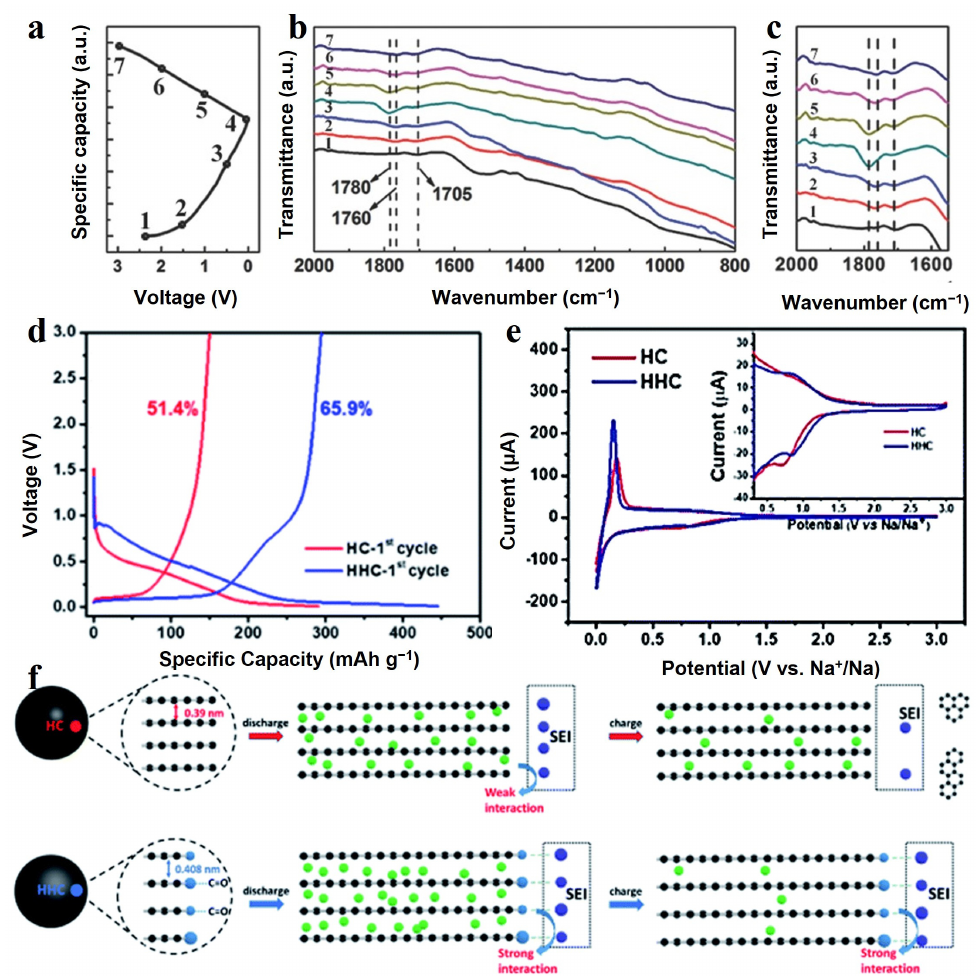
Figure 4. ( a ) Charge/discharge profile of the electrode during the initial cycle at 0.2 A g − 1 , ( b , c ) ex situ FTIR spectra of electrode at the selected potentials indicated in ( a ) [73]. Copyright 2017, Wiley-VCH. ( d ) Galvanostatic charge and discharge profiles of HC and HHC at the first cycle at current density of 100 mA g − 1 . ( e ) CV curves of HC and HHC electrode, inset is the magnified image. ( f ) Proposed mechanism via stabilized solid electrolyte interface between the oxygen functional group and electrolyte [74]. Copyright 2020, Royal Society of Chemistry. (The green and purple circles represent sodium and oxygen atom, respectively. The blue circles represent atoms in SEI. Additionally, electrolyte molecules were illustrated as black hexagonal